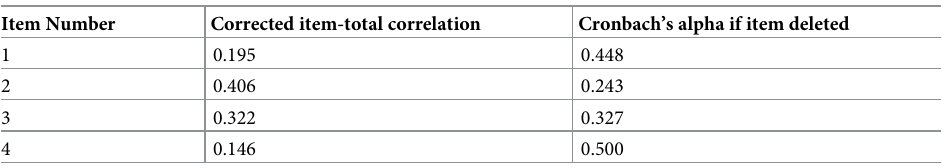
Table 3. Reliability (N = 201).